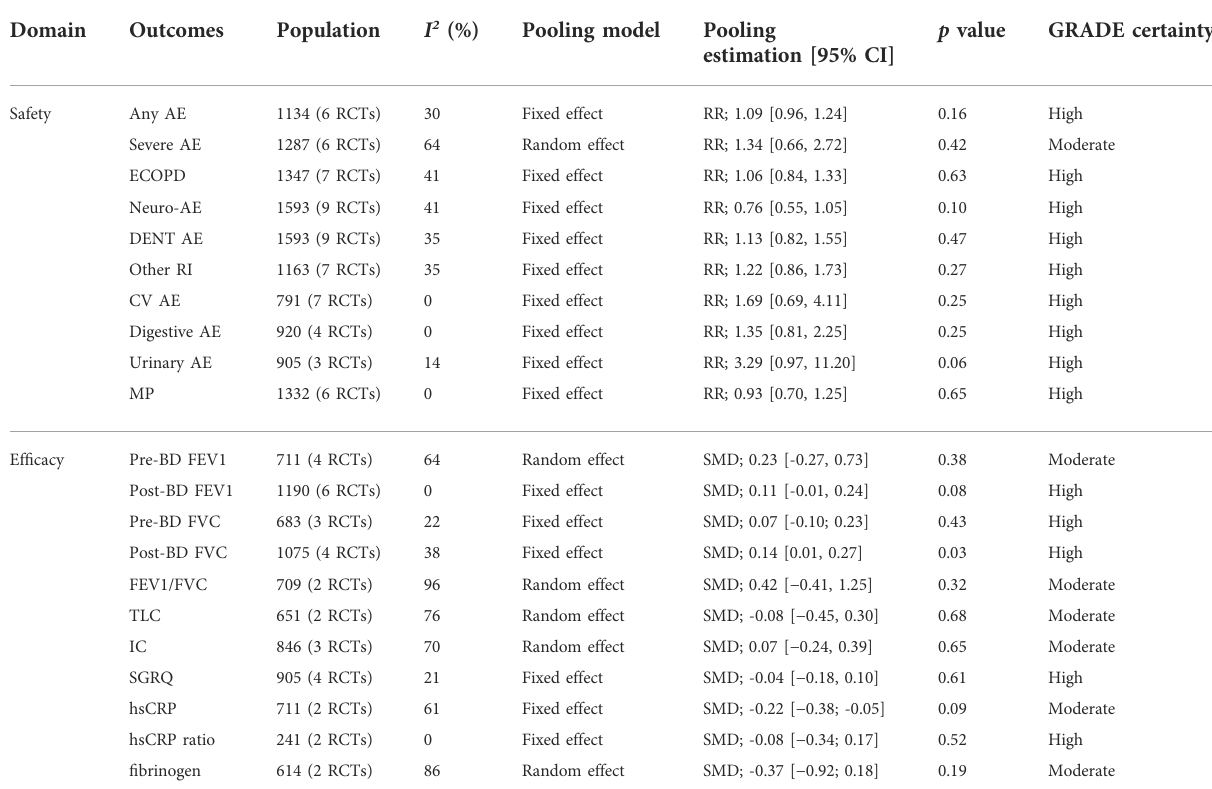
TABLE 5 Summary of fi